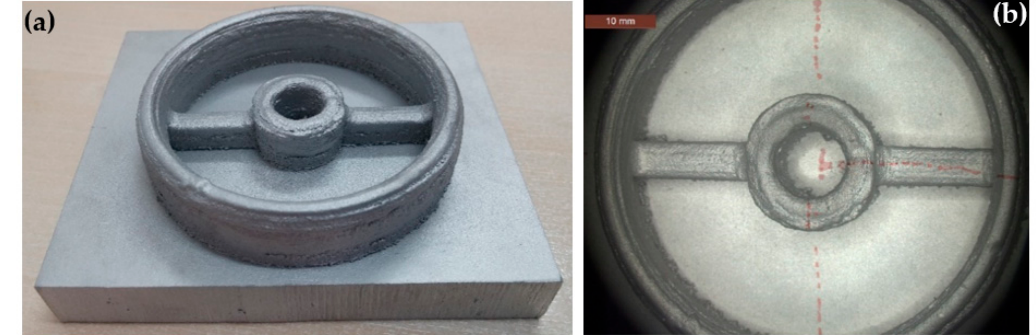
Figure 4. Deposition from scratch of a housing made of Al 4047 alloy by LENS. ( a ) Charge coupled device (CCD) camera view, ( b ) stereomicroscope view.